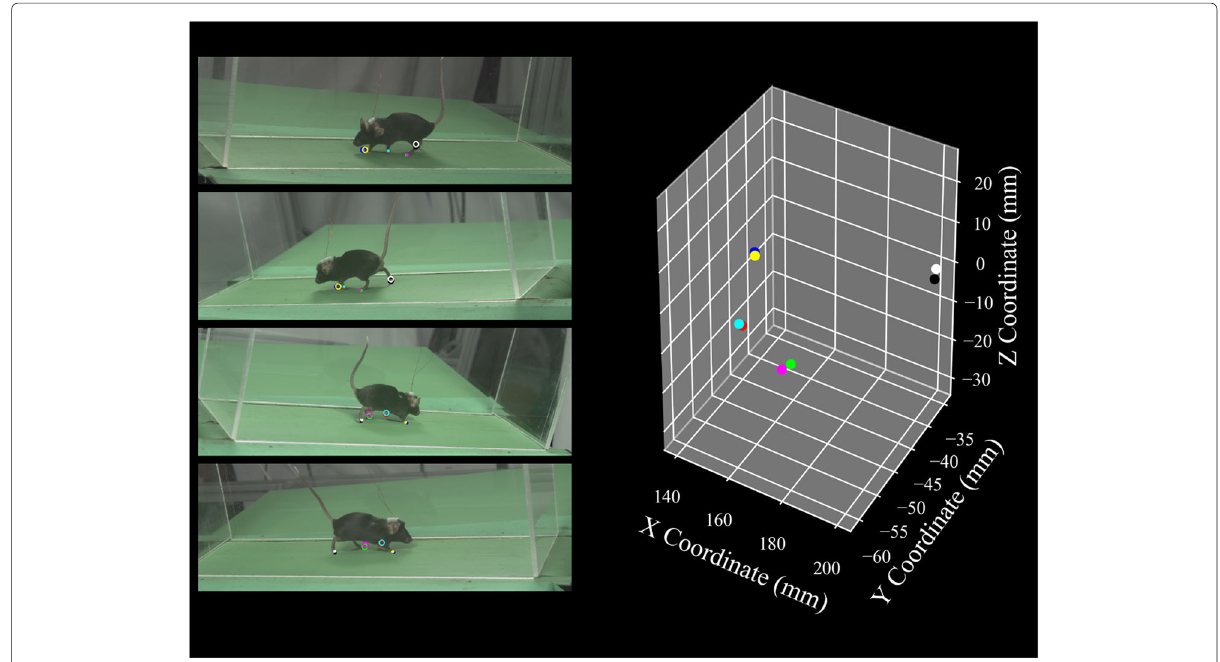
Fig. 8 A video (MP4 82.3MB) of tracked paws for 100 consecutive frames which compare the results between MT and our proposed method (OPM). The filled and unfilled circles show the tracked paws using the cameras located on the same side of paws and the remapped of paws locations to the other side cameras relative to the paw side, respectively. The unfilled circles show the concept of transferring 2D coordinates to 3D and remapping the 3D coordinates to 2D images (in this figure to other cameras while it can come back to the same cameras and finding the 3D reconstruction error). The red, blue, green, black, cyan, yellow, magenta, and white show the tracked coordinates of paws for front right by MT, hind right by MT, front left by MT, hind left by MT, front right by OPM, hind right by OPM, front left by OPM, and hind left by